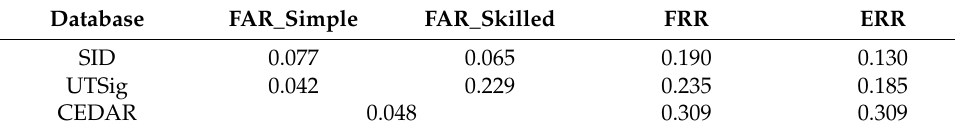
Table 6. Results of verification without